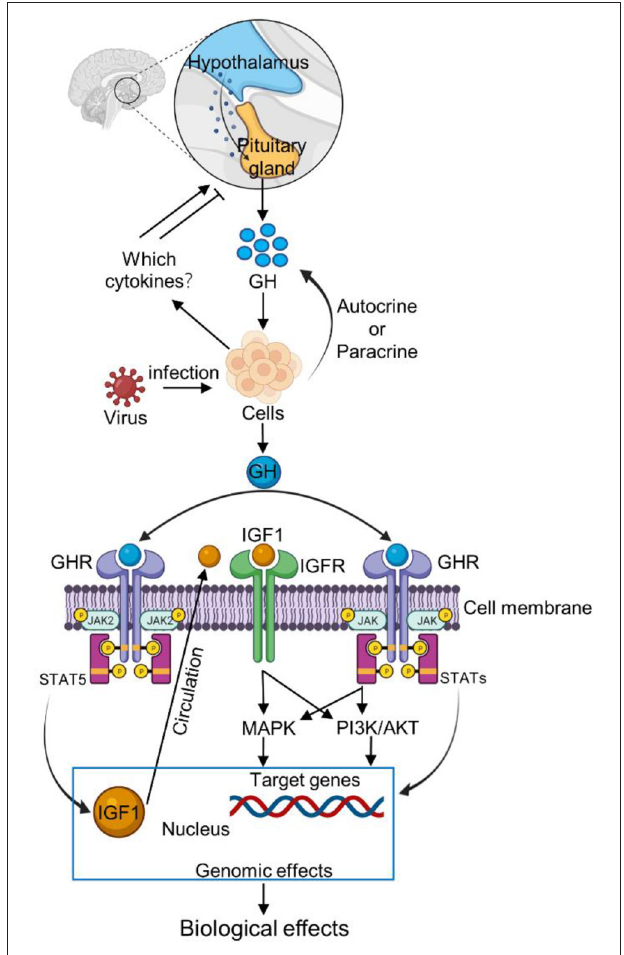
FIGURE 2 | Schematic representation of GH signaling pathway after virus infection. The interactions between GH and cytokines are ambiguous and contradictory but the ghrelin can induce GH secretion. After virus infection, the host cells increase the expression of ghrelin. Ghrelin stimulates the pituitary gland to increase GH secretion. Meanwhile, cells can also increase GH secretion by autocrine or paracrine pathways. Then GH binds to the GHR receptor on the cell membrane, and activates JAK/STAT, MAPK and PI3K signaling pathways, thus regulating the individual immune response. Moreover,